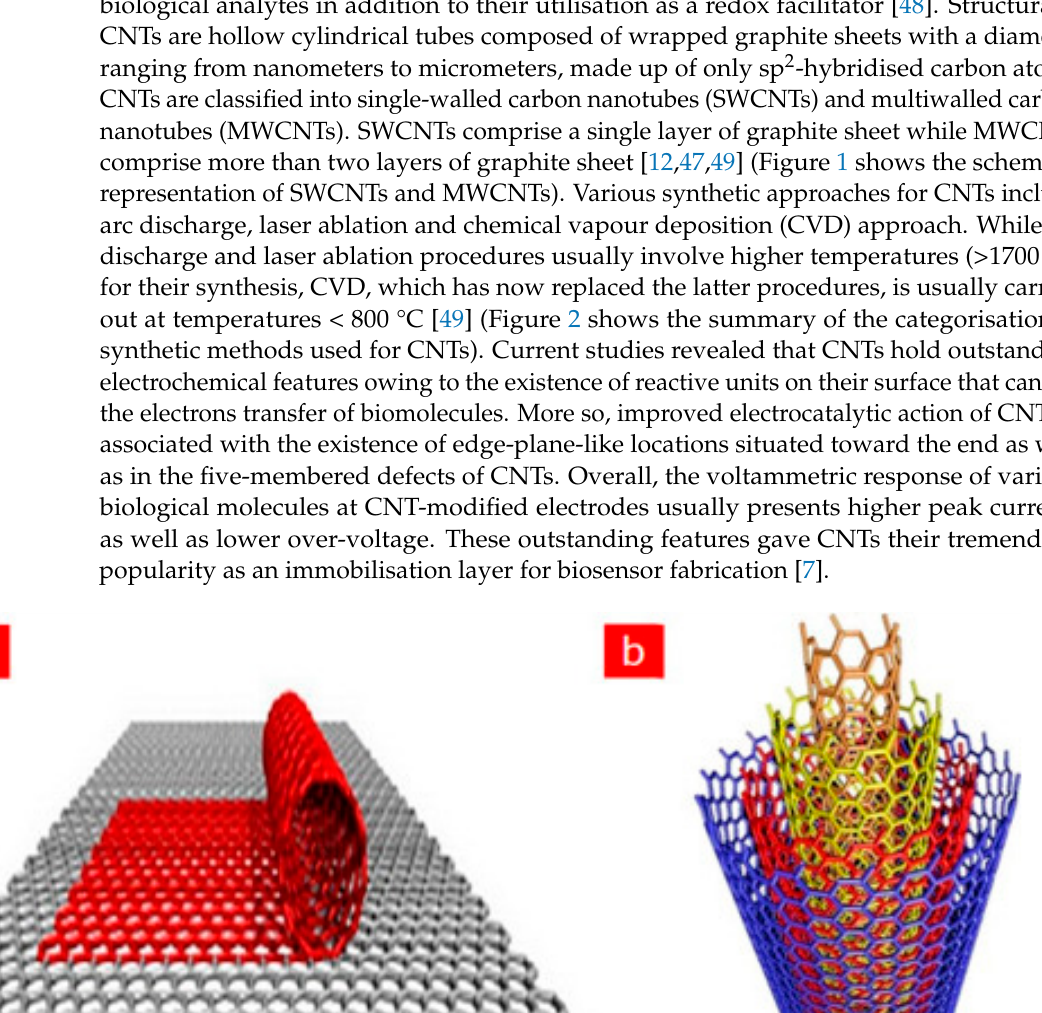
Figure 2. Categorization of synthesis methods used for carbon nanotubes. Adapted from Ref. [49] with Permission from RSC Advances. Furthermore, functionalisation of the physical and chemical features of nanoparticles is imperative to customise their use in electrochemical biosensors. This is often carried out by attaching some molecules on their surface. As a practical illustration, CNTs are insol- uble in aqueous solutions; however, when they undergo oxidation in acidic mixtures the carboxylic units attached to the surface as well as the side walls of the nanotubes make them soluble in aqueous solutions. Hence, functionalisation has proven to be an effective means of altering the physical and chemical features of CNTs [50–52]. Notably, function- alisation of CNTs in surfactants containing solutions or with chemicals normally leads to a decrease in their bundle formation [53]. Covalent and non-covalent attachment are means by which CNTs can be functionalised with various chemical units and this makes them biologically compatible for conjugation with biomolecules, thus becoming promis- ing immobilisation candidates for biosensor design [1,52]. Kumar et al. also added that amine and carboxyl functional units normally increase the electron transfer rate. In prac- tice, they mentioned that water-based polymers built functionalisation of CNTs or surface